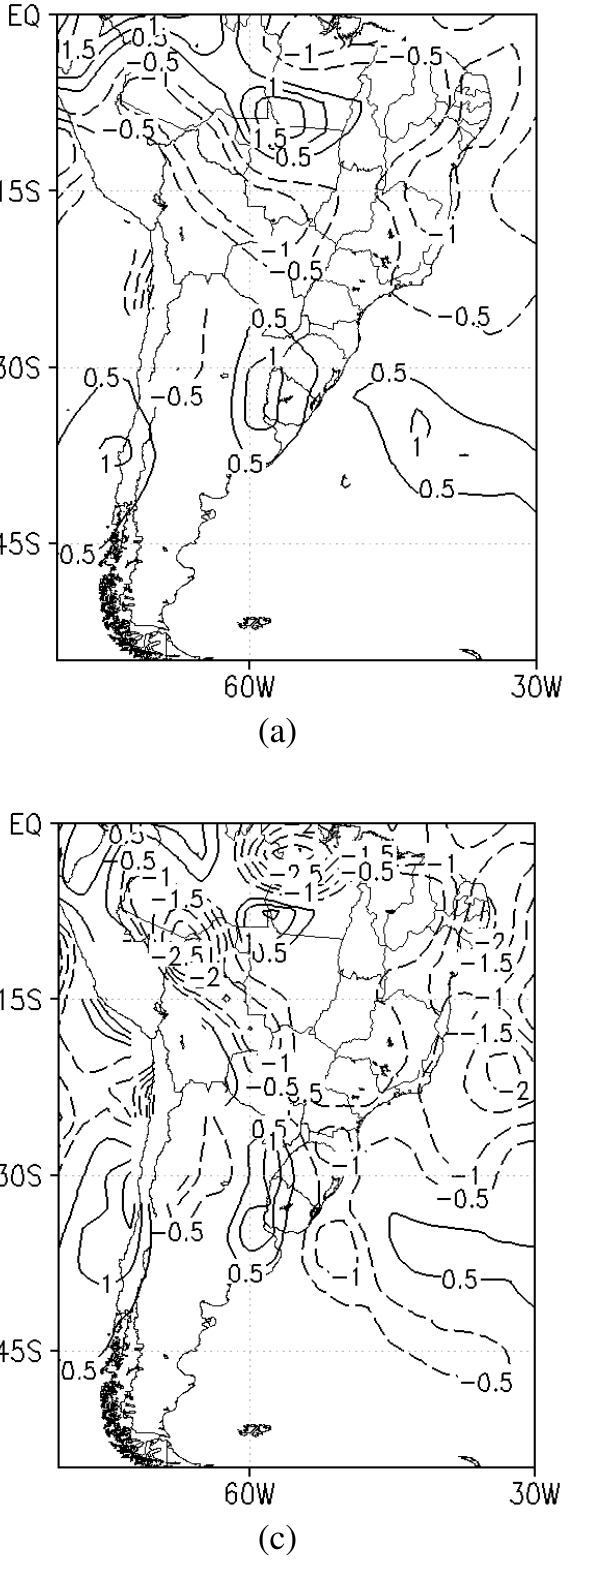
Fig. 18. Episode-mean fields vertical advection of humidity (gkg − 1 day − 1 ) : (a) 700hPa, Case 29, (b) 700hPa, Case 32, (c) 850hPa, Fig. 18 – Episode-mean fields of vertical advection of humidity (g kg -1 day -1 ): (a) 700 hPa, Case 29, and (d) 850hPa, Case Case 29, (b) 700 hPa, Case 32, (c) 850 hPa, Case 29, and (d) 850 hPa, Case 32.